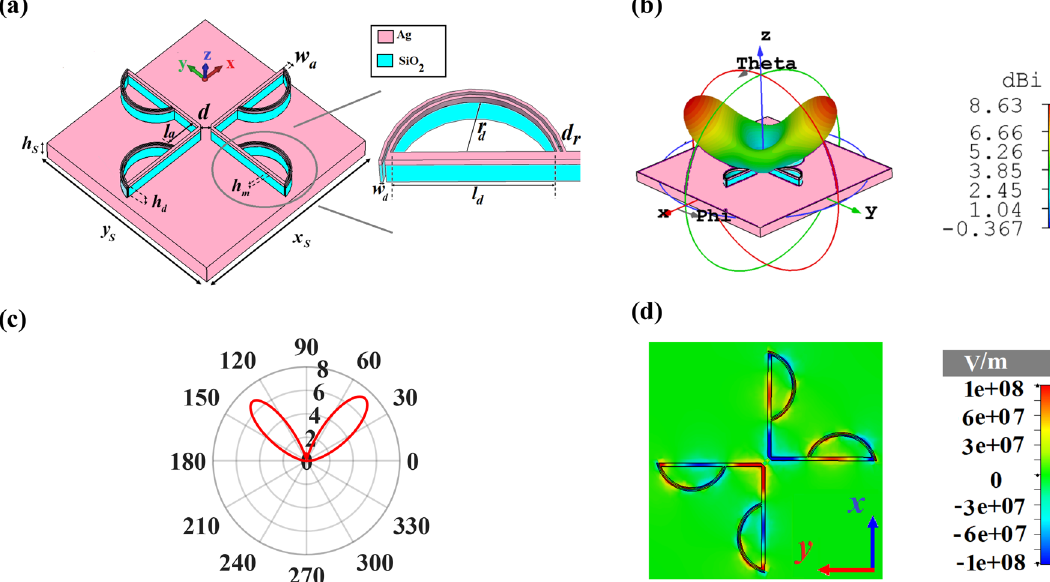
Figure 4. ( a ) 3D perspective view of bidirectional cross dipole nano-antenna with circular directors. ( b ) 3D and ( c ) 2D polar plot of directivity radiation patterns and ( d ) the z-component of electric field